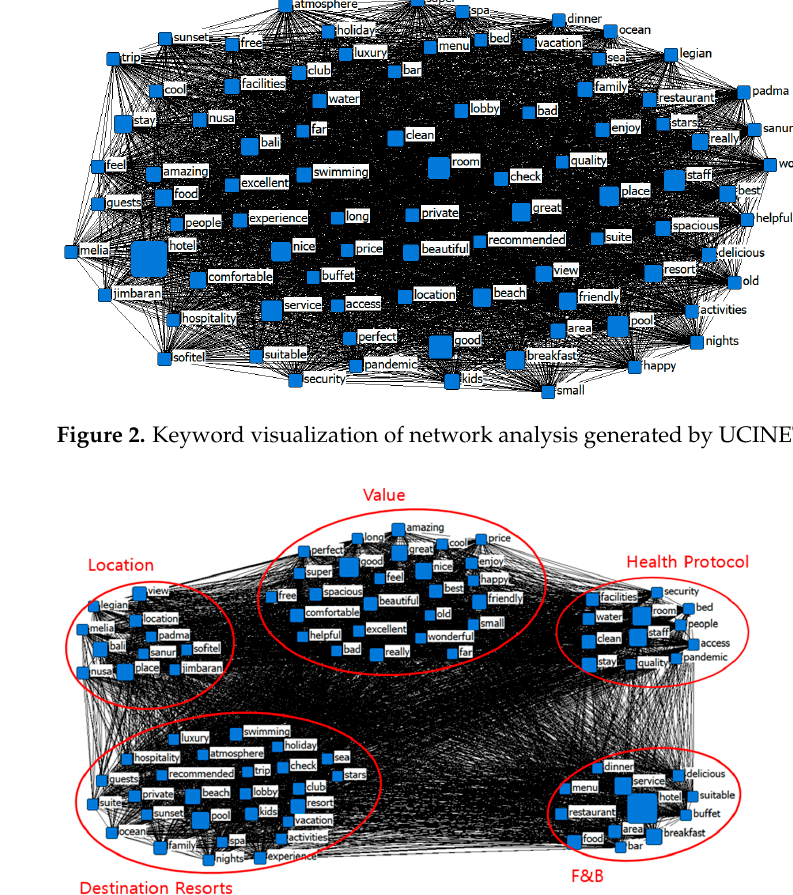
Figure 3. Visualization of Convergence of literated Correlation (CONCOR) analysis. Table 5. Result of CONCOR